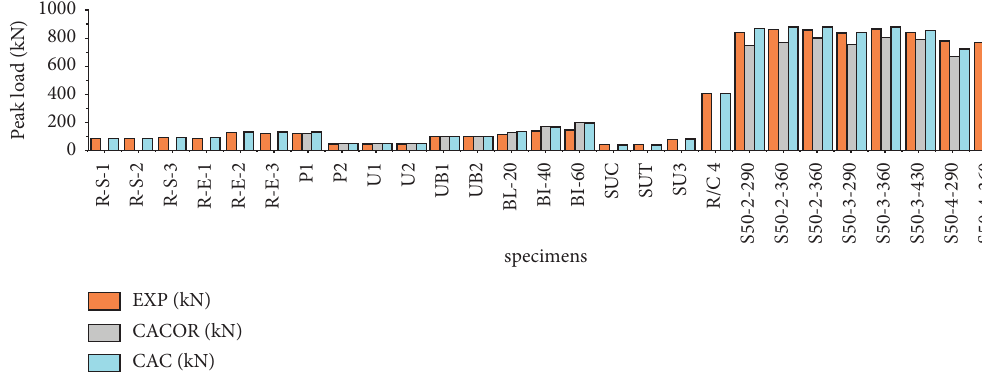
Figure 10: Comparison between the experimental value and calculated value of peak load.